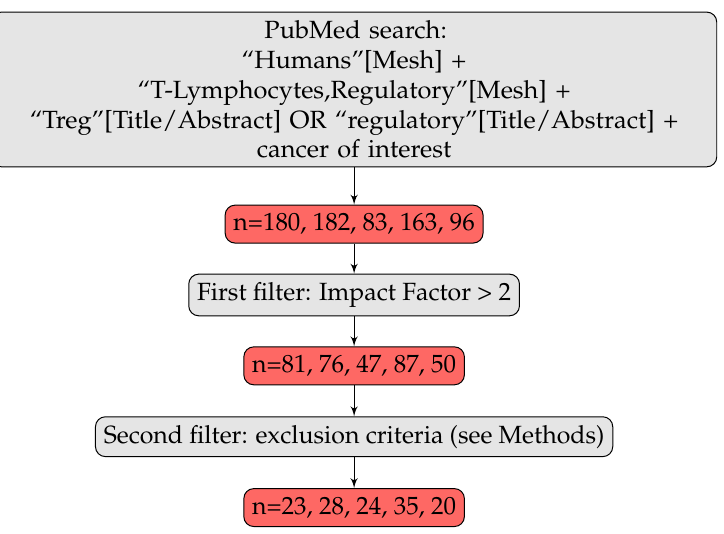
Figure 1. Article selection strategy. n is the number of articles retained at each step for the vari- ous types of cancer considered, listed in the following order: breast, colorectal, gastric, lung and ovarian